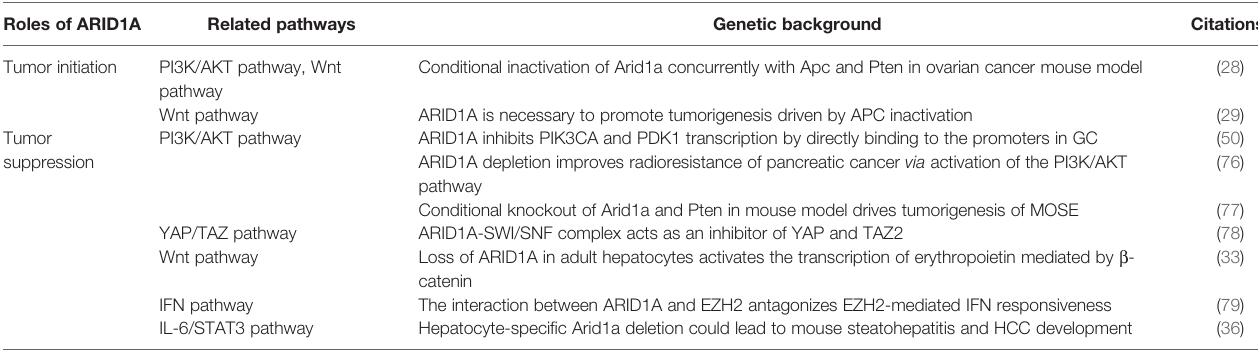
TABLE 2 | Signaling pathways related to the roles of ARID1A in tumor initiation and tumor suppression. Roles of